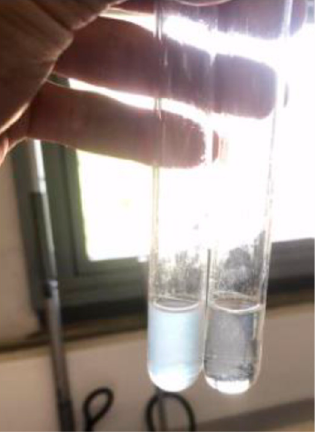
Figure 3. Untreated ( left ) and treated ( right ) with 0.5 g/L of DCMC samples of Moscatel de Setúbal wine following a HST.